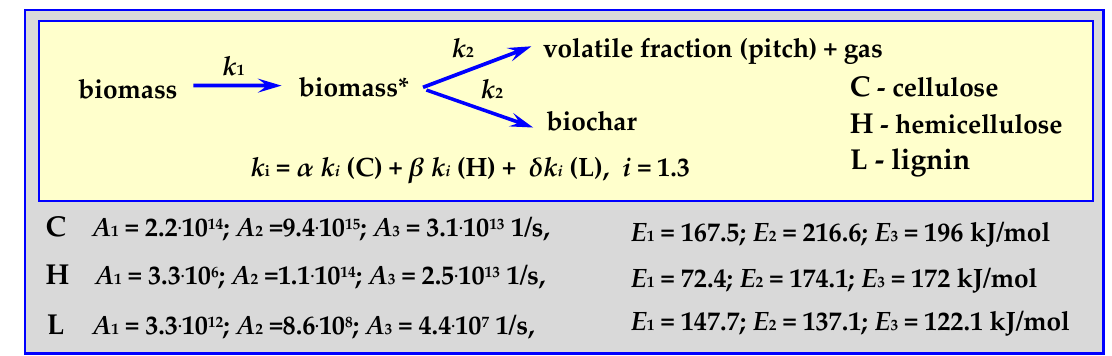
Figure 10. Koufopanos semi-whole mechanism marked as K in Figure 12.